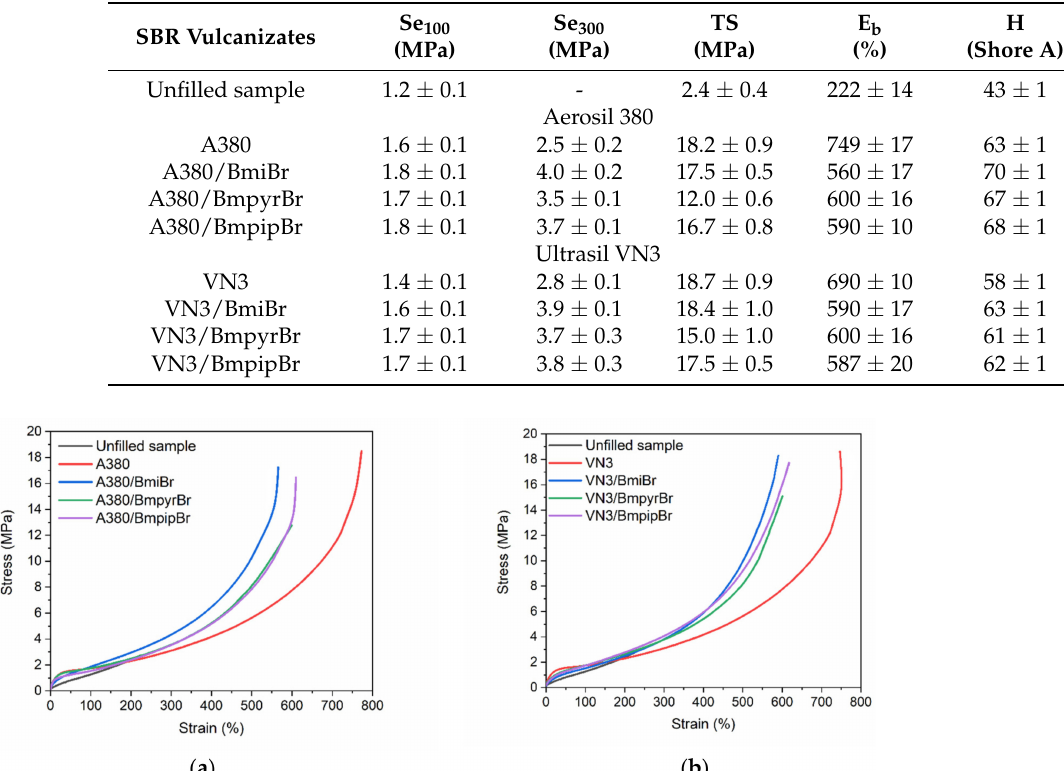
Table 6. Mechanical properties and hardness of SBR vulcanizates filled with A380 and VN3 silica (Se 100 , stress at 100% relative elongation; Se 300 , stress at 300% relative elongation; TS, tensile strength; E b , elongation at break; H, hardness).